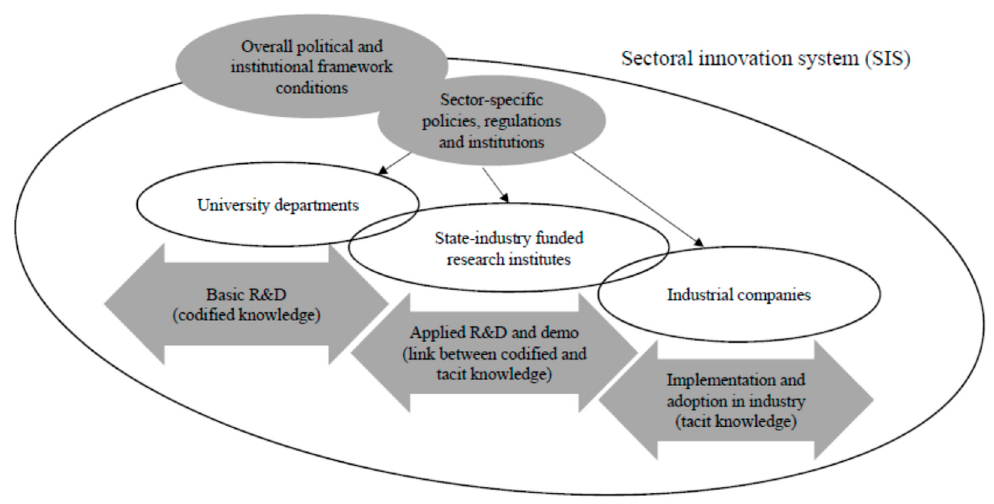
Figure 1. Analytical Framework: Sectoral Innovation System and Technological Development.